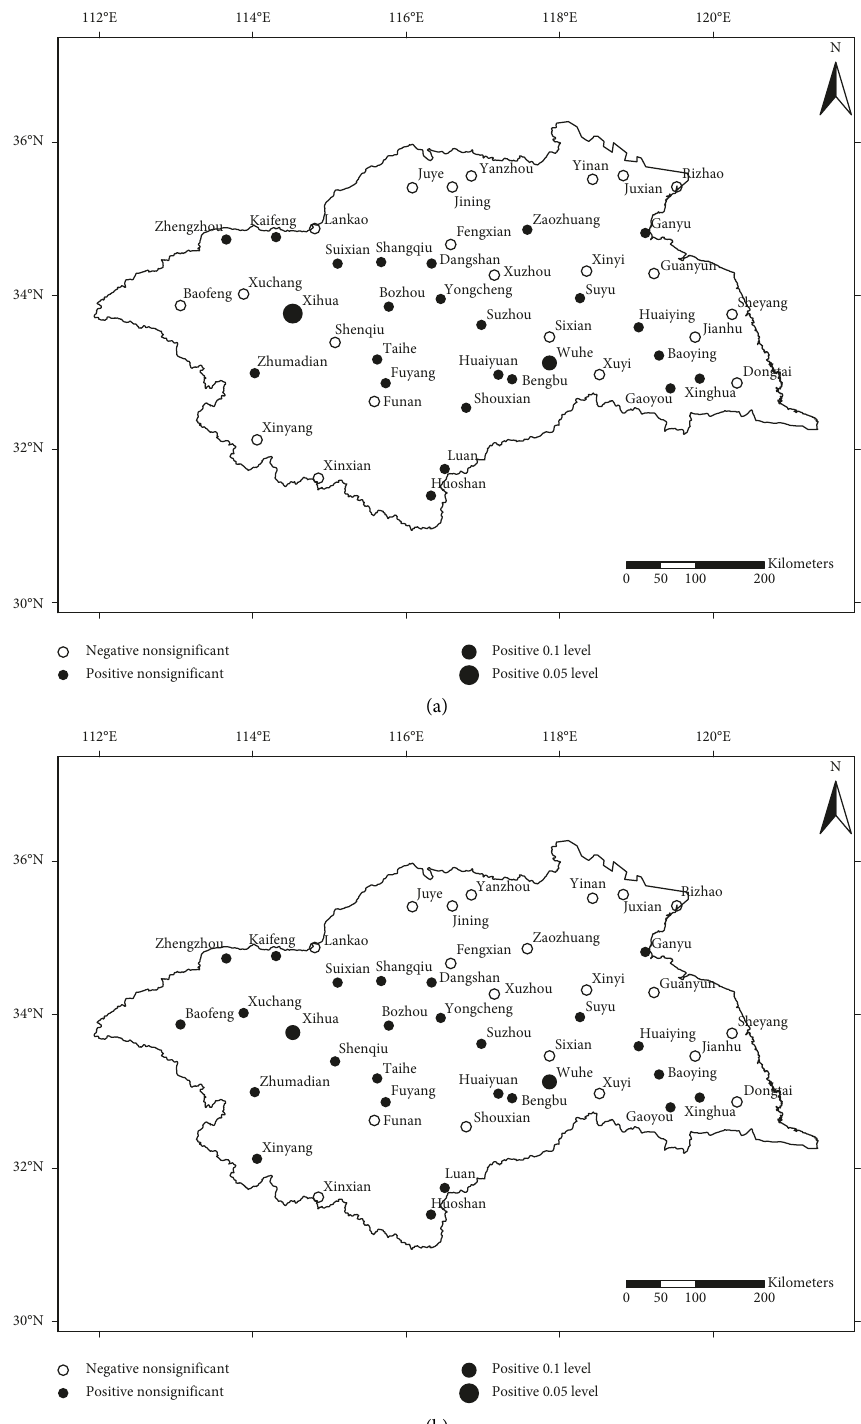
Figure 2: Spatial pattern of the Mann–Kendall trend of extreme precipitation indices of (a) PX5D and (b) PX10D in the of the drought areas in Figures 4(b) and 4(d). The correlation good correspondence between the peaks/valleys of PX5D/ coefficients between PX5D (PX10D) and flood and drought PX10D and the floods/droughts in the basin (Figure 4). The damaged areas are 0.50 (0.59) and − 0.38 ( − 0.47) during the peaks and valleys of PX5D and PX10D are consistent with period from 1960 to 2000, respectively, all of which reaching those of the flood areas in Figures 4(a) and 4(c), while the 0.05 significant level. PX5D and PX10D were mainly at their peaks and valleys of PX5D and PX10D are in reverse to those